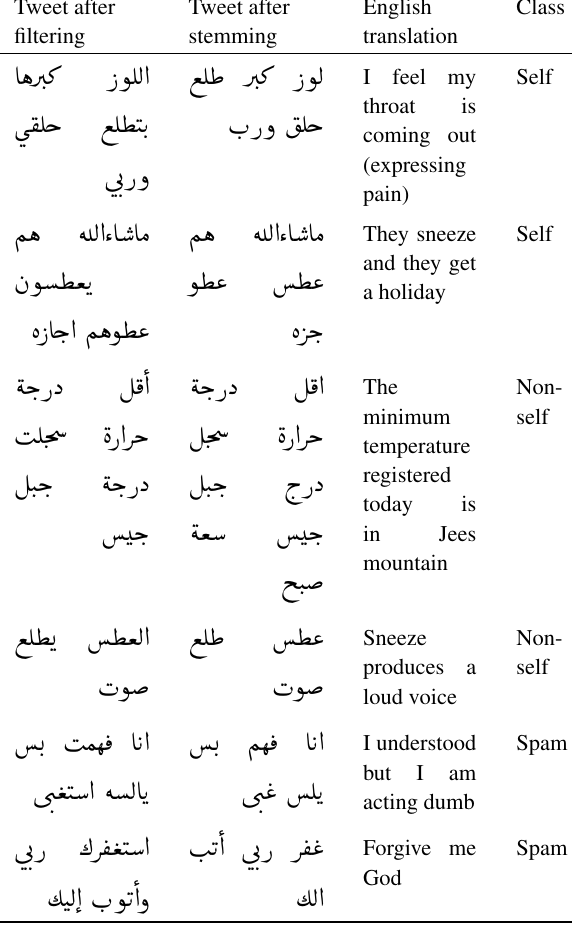
Table 3 Examples of stemmed Arabic tweets. Tweet after Tweet after English filtering stemming translation